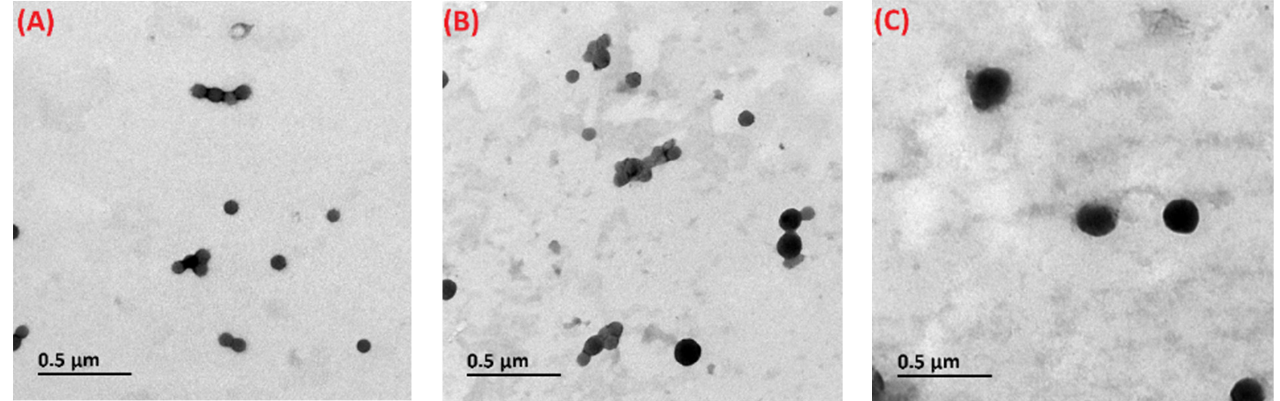
Figure 5. TEM images of DHF-S/Z ( A ), DHF-CMC/S/Z ( B ) and DHF-ALG/S/Z ( C ), 30,000× magnification times.